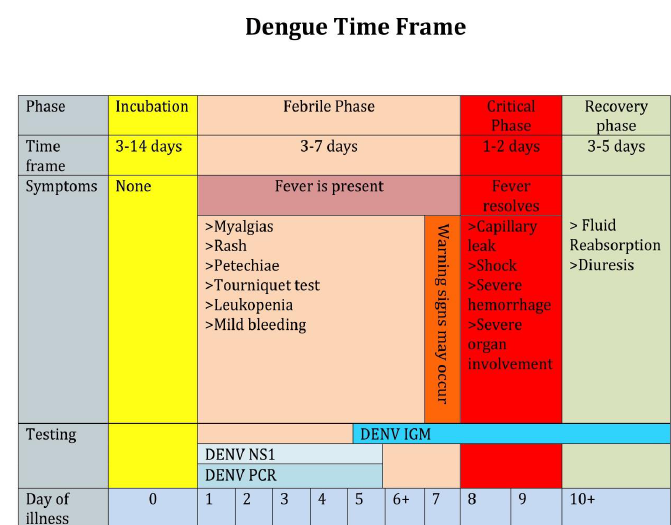
Figure 3. Three distinct phases of dengue infection have been described: incubation, febrile, and recovery. The critical phase, when patients may become unstable, typically occurs after defervescence of the fever. Although most patients will improve after the febrile stage, those who progress to the critical phase may display warning signs. By closely monitoring for these signs, clinicians can identify and appropriately disposition patients at higher risk for a more severe clinical course. The laboratory evaluation of dengue also varies based on the stage of infection and thus samples evaluating for both viral practices (PCR or NS1) and IgM levels should be ordered. DENV, dengue virus; NS1, nonstructional protein 1; PCR, polymerase chain reaction *PCR is expressed on the surface of infected cells.